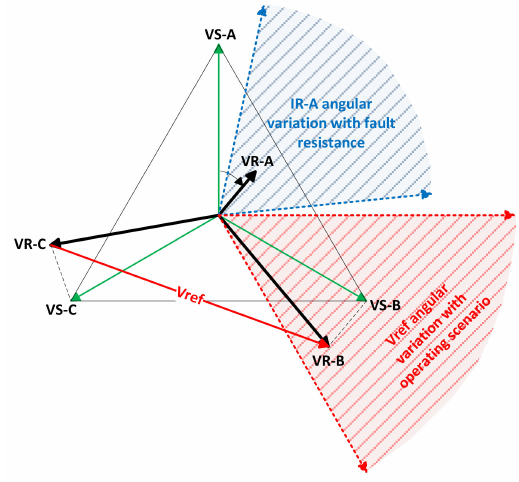
Figure 1. Variation of the polarization variables according to the two main factors a ff ecting the cross-polarization